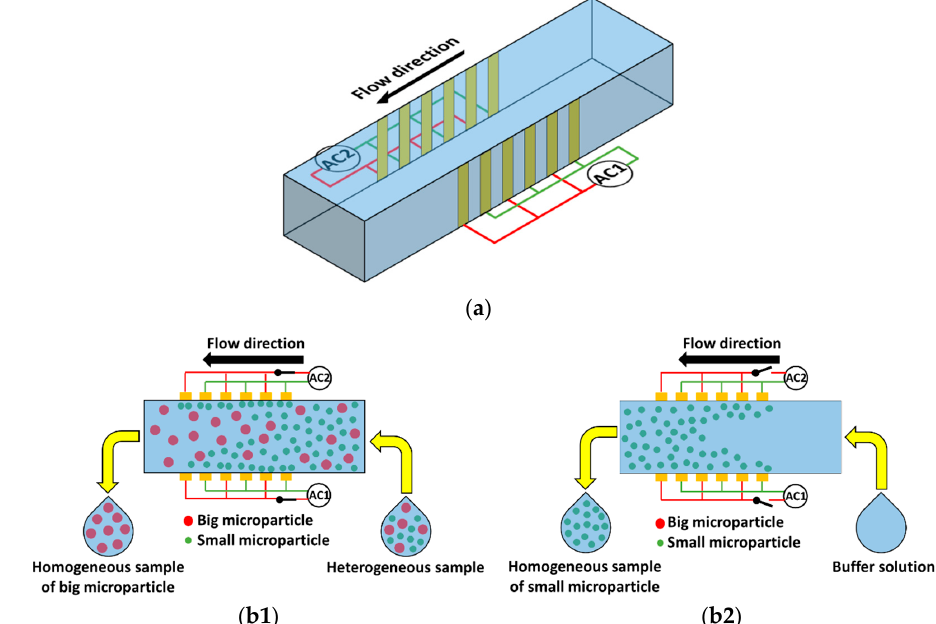
Figure 1. Schematic of the ( a ) proposed microfluidic device (perspective view) and (b) working of the device; ( b1 ) capture of small microparticles on electrodes and collection of big microparticles at device exit during sample processing (top view) and ( b2 ) collection of small microparticles at device exit after their release from electrodes while flushing device with buffer solution (top view).